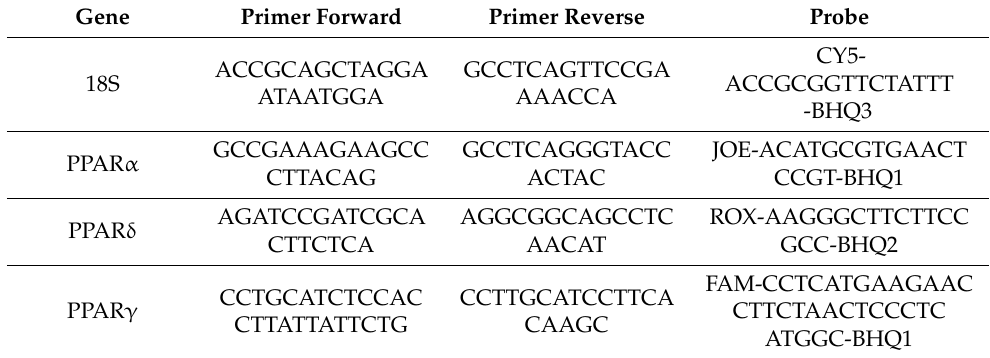
Table 1. Gene-specific oligonucleotide primers and probes of PPAR family for RT-qPCR.